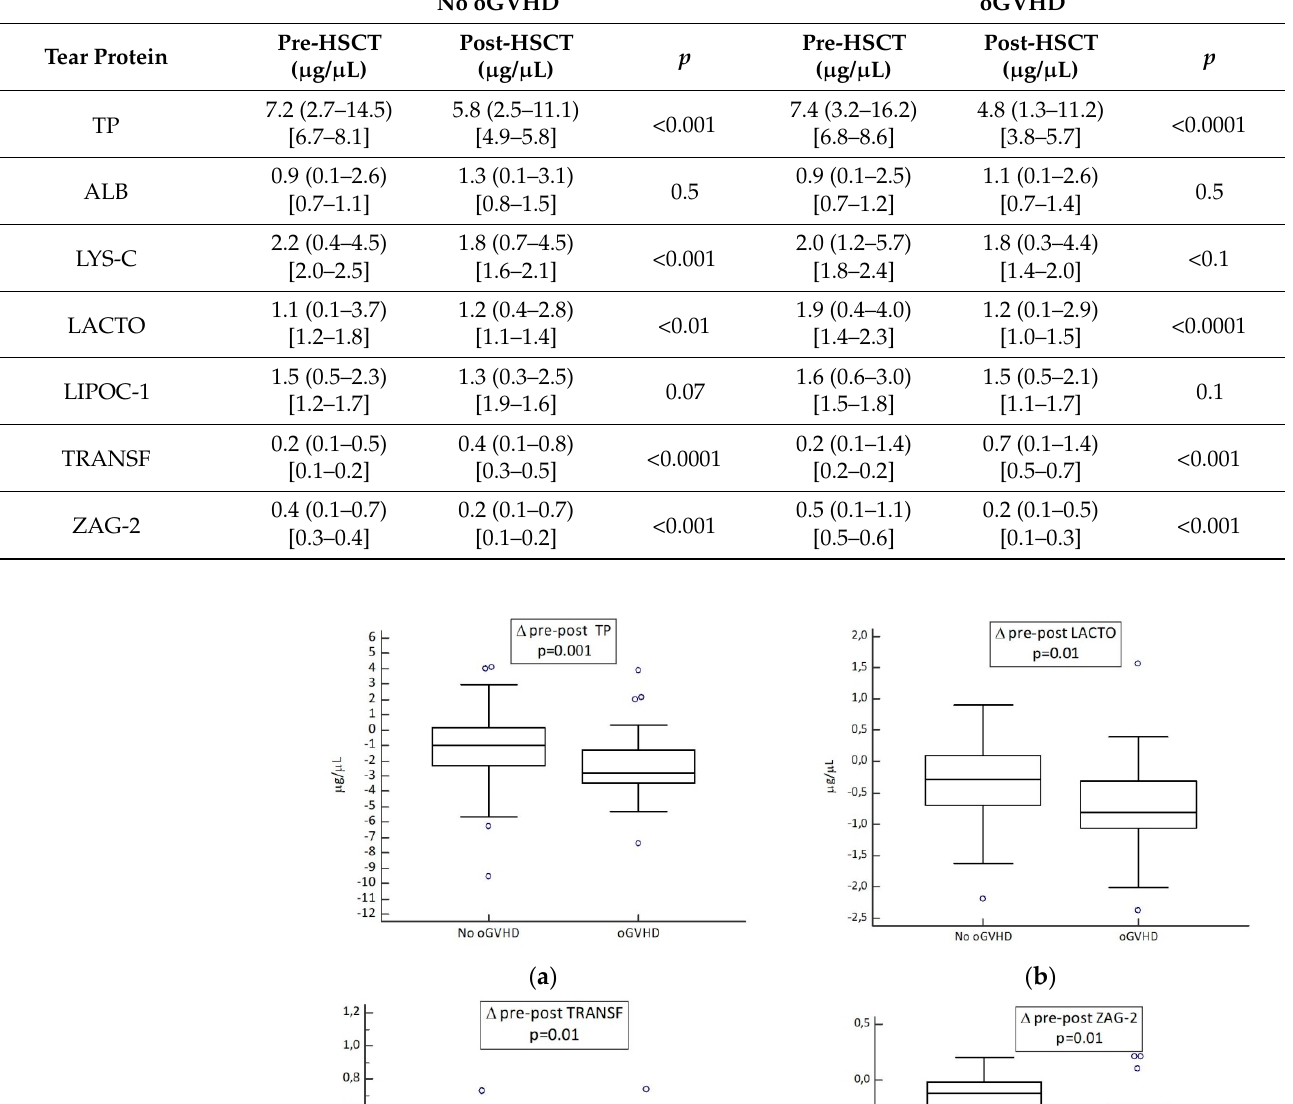
Table 4. Comparison of levels of tear proteins analyzed pre and post-hemopoietic stem cell transplant (HSCT) in patients with or without ocular graft versus host disease (oGVHD). Data are expressed as median (min-max) [95% CI]. TP = total protein; ALB = Albumin;